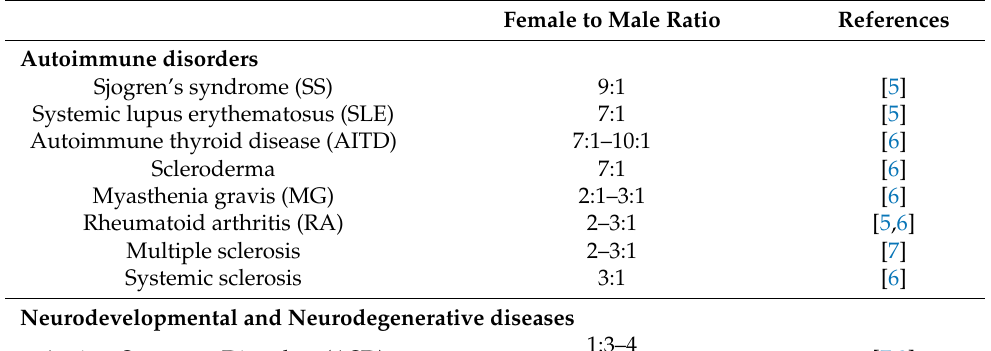
Table 1. Examples of the female:male ratios for